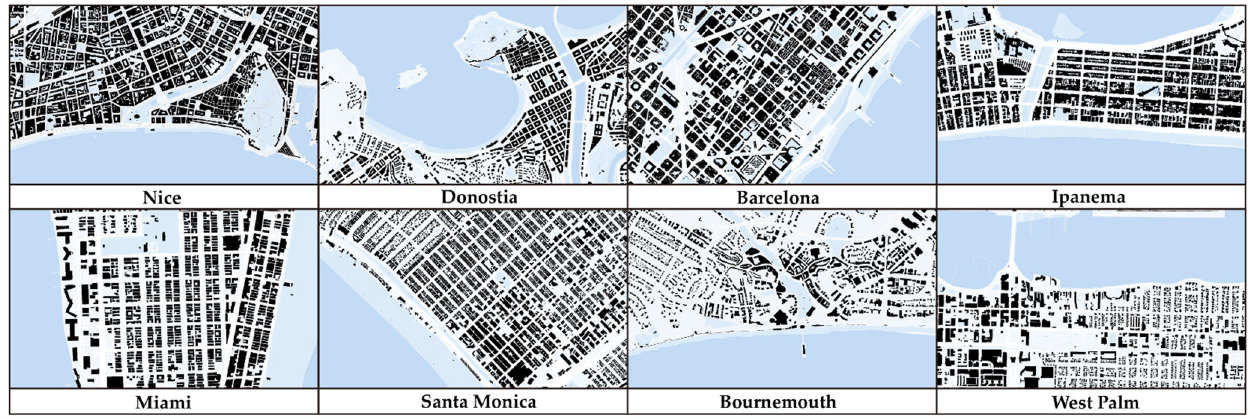
Figure 10. The Figure ‐ Ground in successful coastal